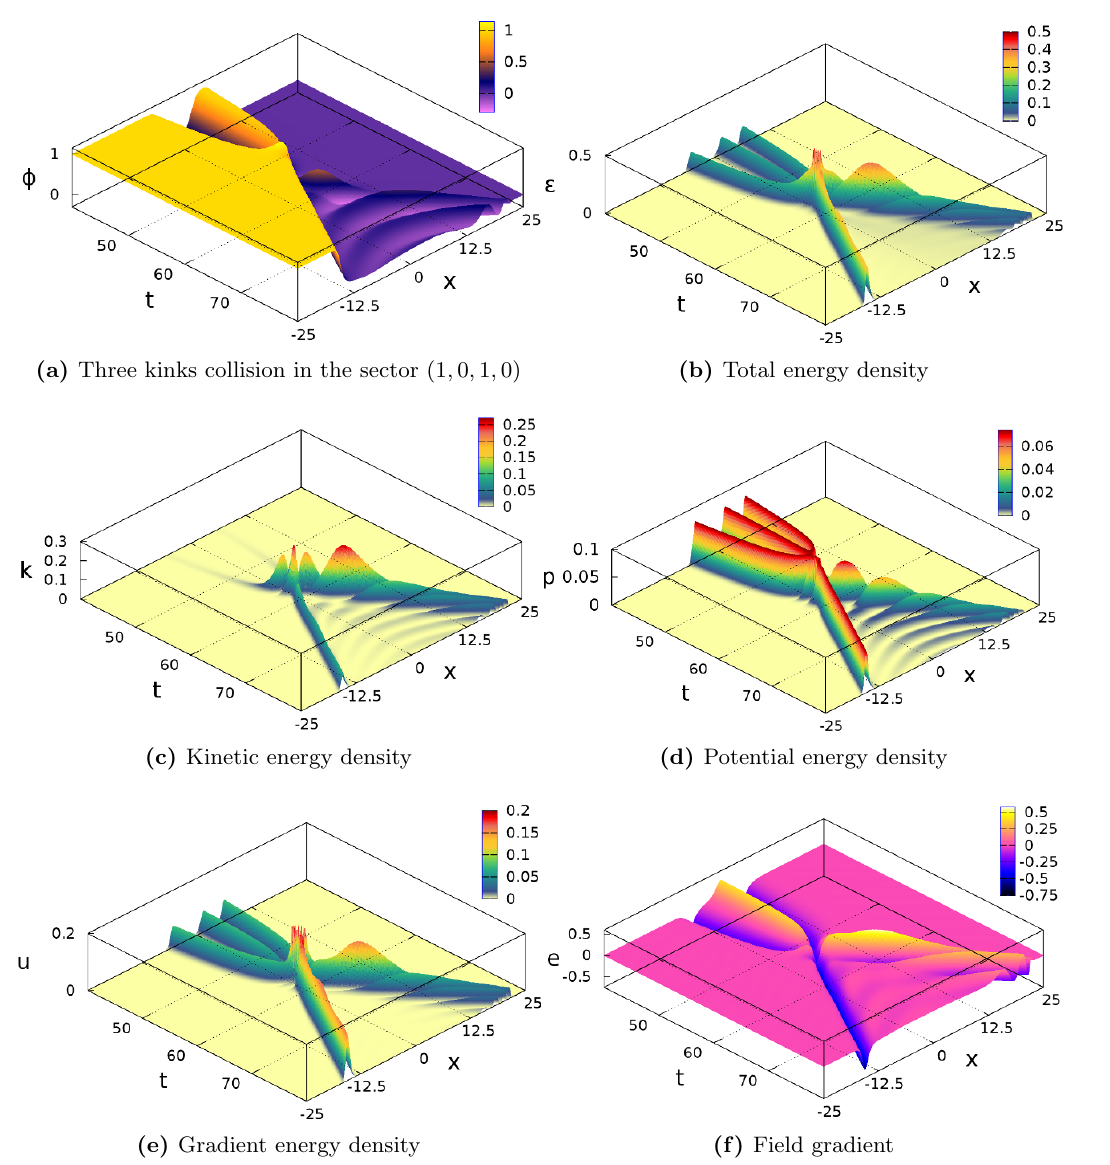
Figure 6. Space-time picture of collision of three kinks in the case of initial con(cid:12)guration (1 ; 0 ; 1 ; 0). x = 2 : 06000, see (cid:12)gure 6a. As in the previous case, the position x 2 ensures that both antikinks arrive at the location of the kink at the same